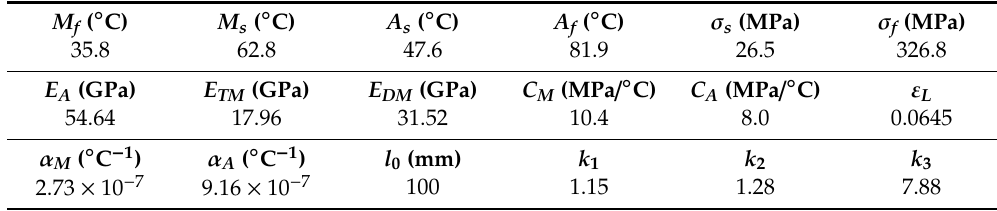
Figure 1. Relationship between temperature, stress, and strain of the shape memory alloy (SMA). Table 1. Thermal and mechanical parameters of the SMA.